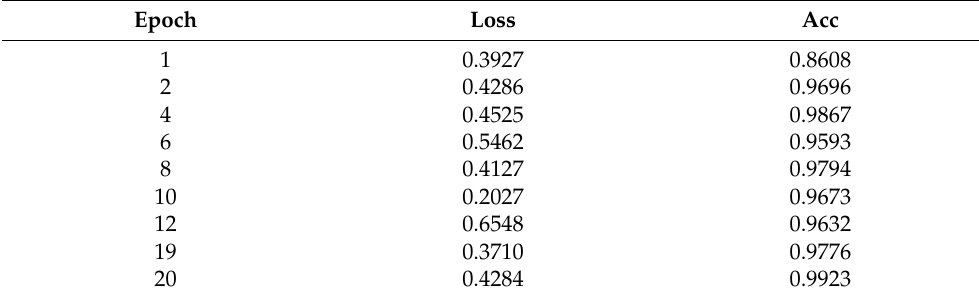
Table 1. Loss and Acc results for function values training and validation data on the ResUNet model for liver segmentation using a different number of epochs.